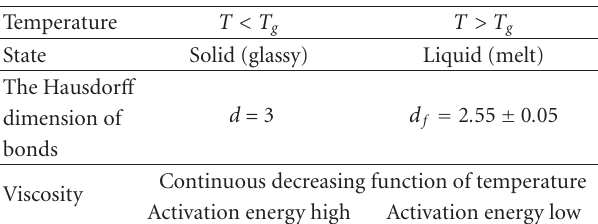
Table 7: Viscosity and bond geometries of amorphous materials. Temperature T < T g T > T g State Solid (glassy) Liquid (melt) The Hausdor ff d = 3 d f = 2 . 55 ± 0 . 05dimension of bonds Continuous decreasing function of temperature Viscosity Activation energy high Activation energy